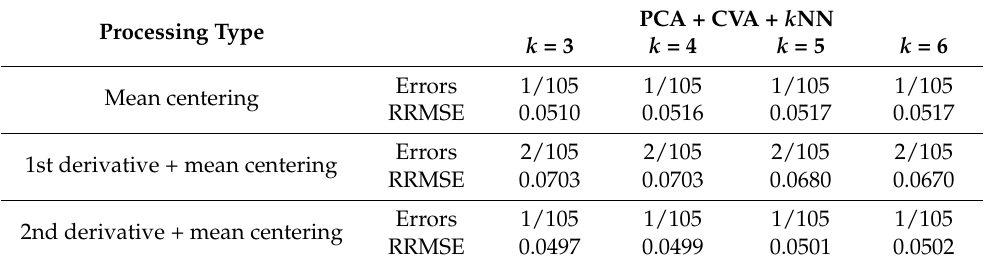
Table 3. Study No. 1 with MIR Spectral Data. Prediction-Set Classification Errors (105